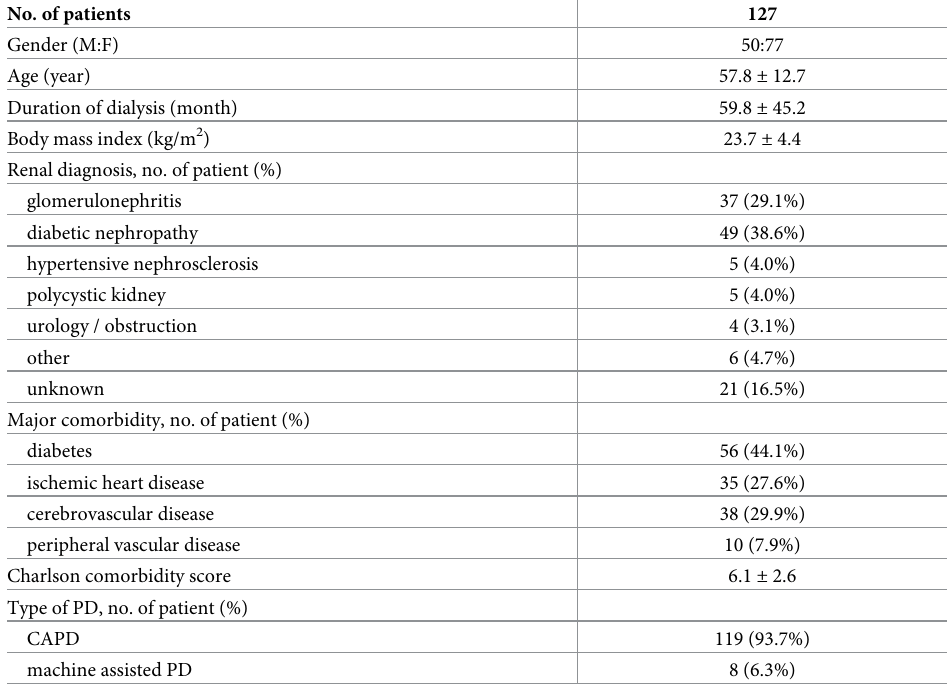
Table 1. Baseline characteristics of the patients (cid:3)